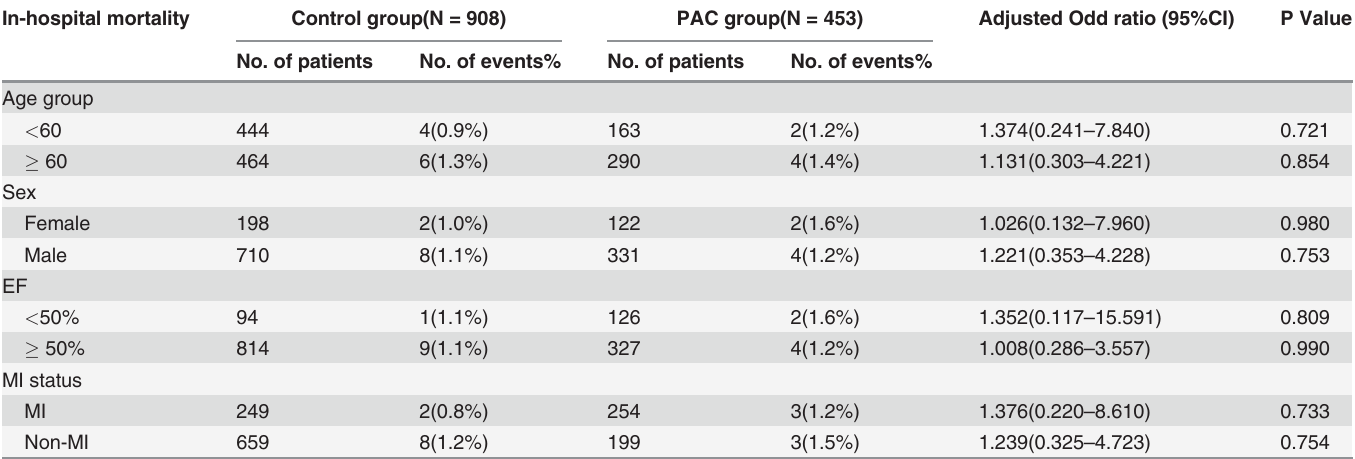
Table 4. Subgroup analysis: The impact of pulmonary artery catheter use on in-hospital mortality. In-hospital mortality